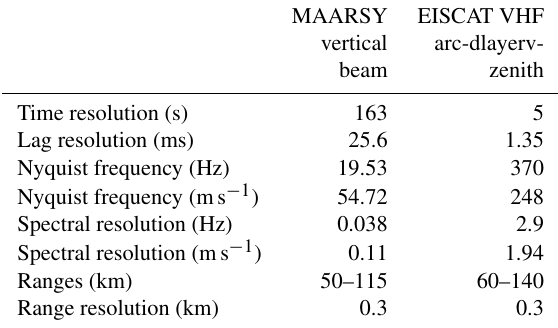
Table 2. Radar experiment